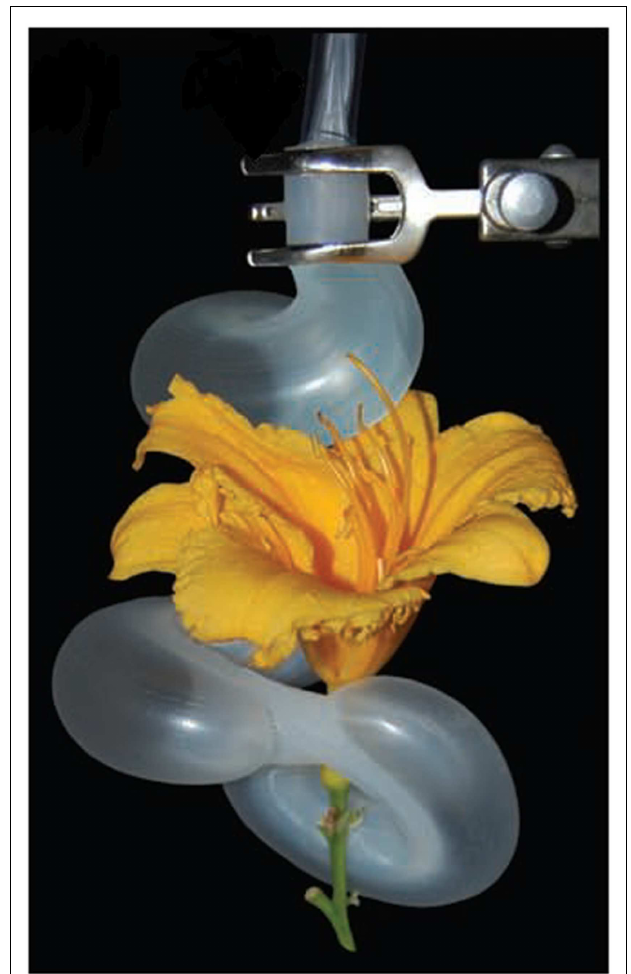
FIGURE 1 | Pneumatic tentacle-like soft manipulator (Martinez et al., 2013) (reproduced with permission from JohnWiley and Sons)